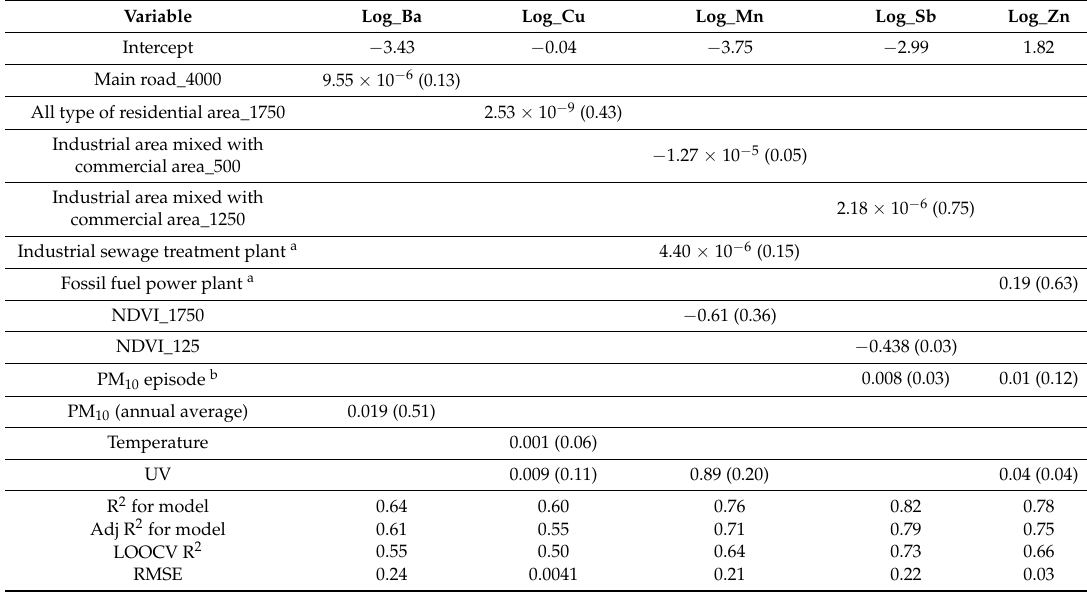
Table 3. Results of LUR models for regression coefficient (partial R 2 ) for metal PM 2.5 -bound